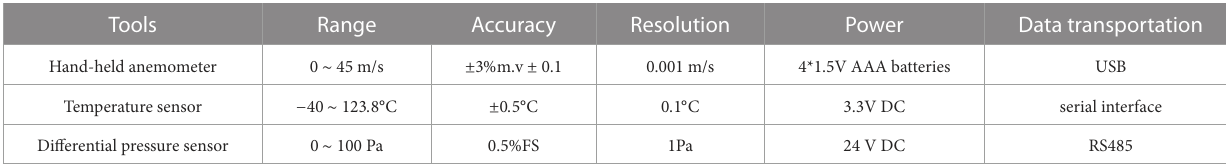
TABLE1 Experimentaltools’specifications.